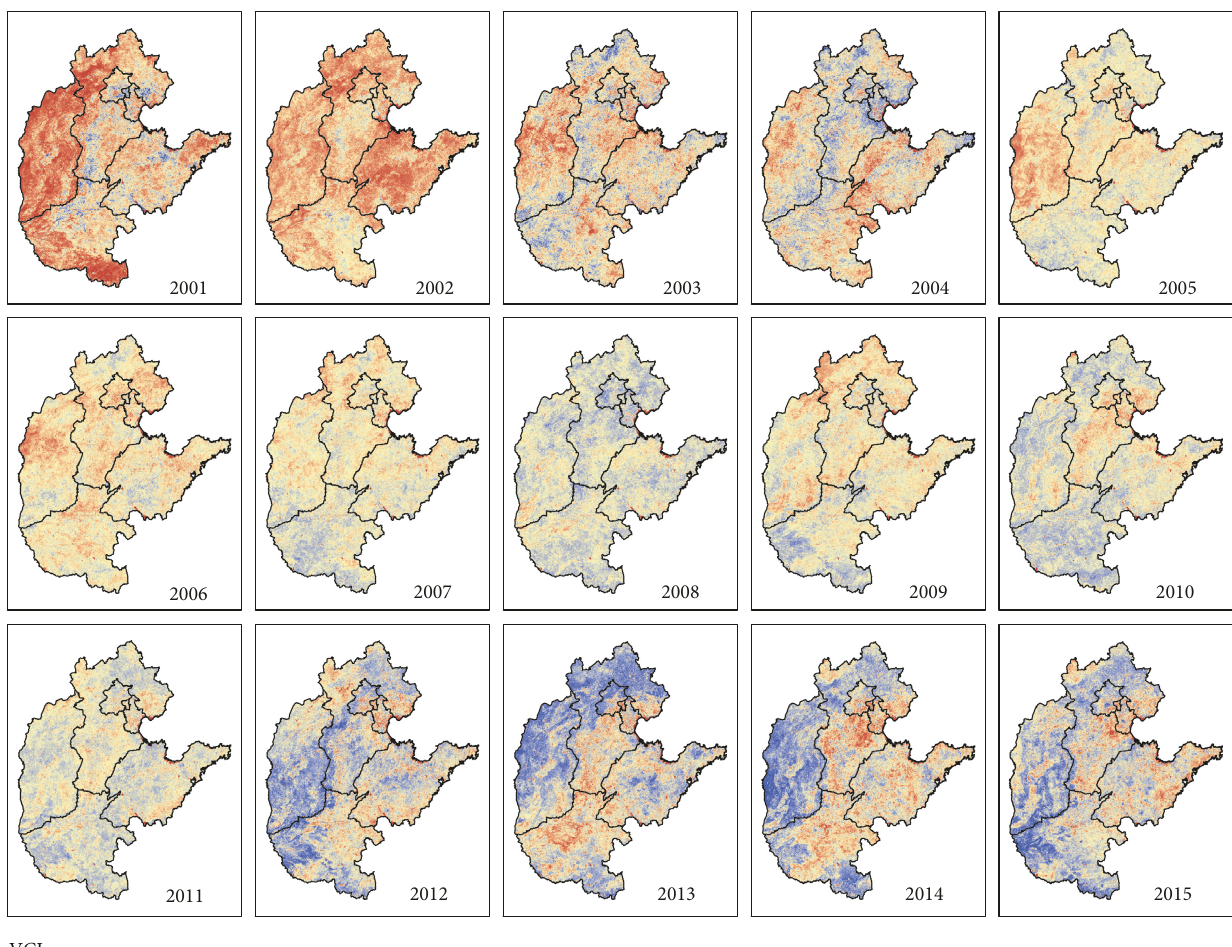
Figure 7: Spatial distribution of annual growing season VCI in North China during